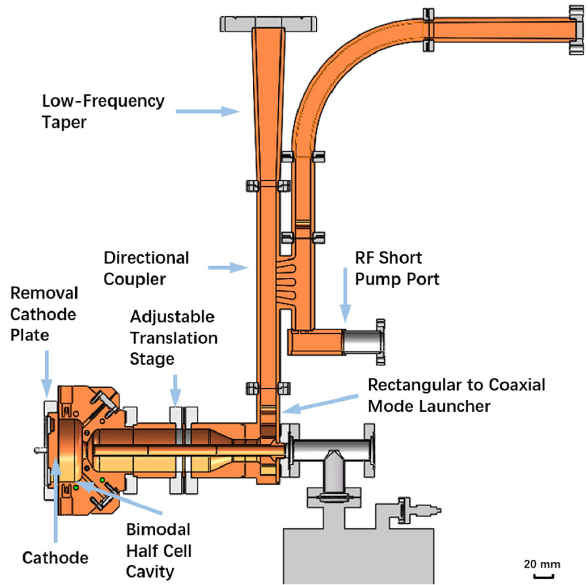
FIG. 8. Engineering drawing of the bimodal